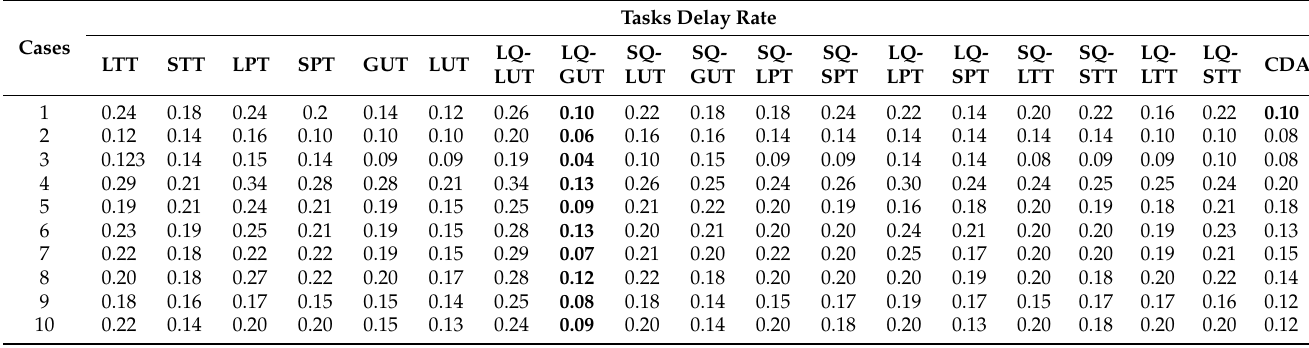
Table A4. Tasks delay rate of CDA algorithm and assignment rules under different cases. Cases